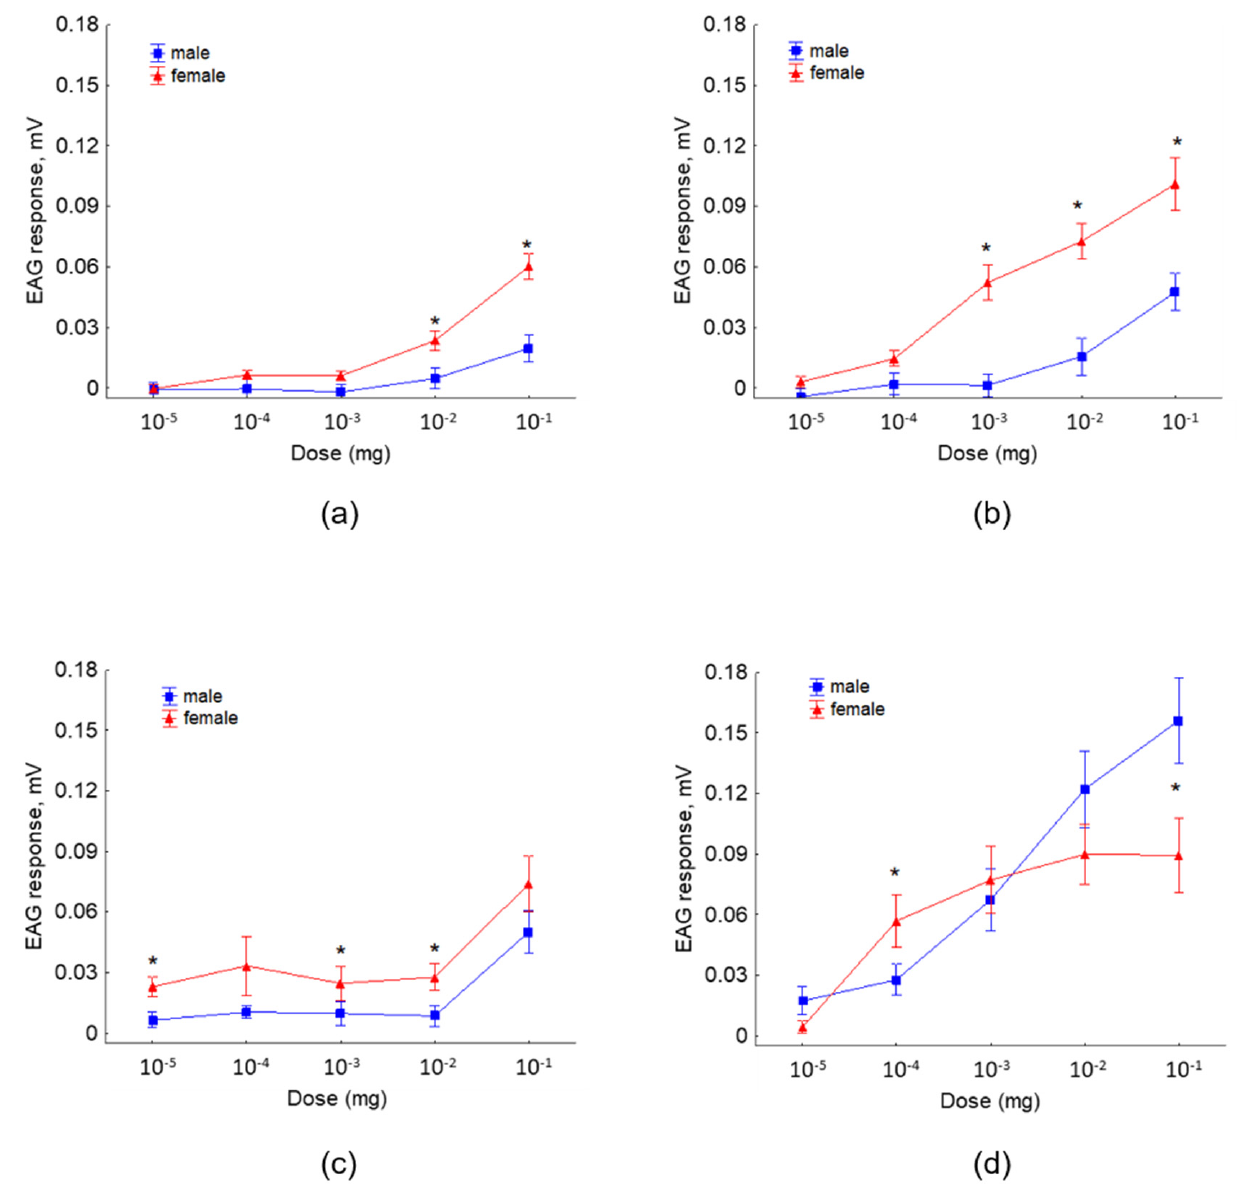
Figure 5. EAG responses (mean amplitude ± standard error (SE), mV) of R. cerasi male and female antennae to different doses (10 − 5 to 10 − 1 mg) of synthetic: ( a ) 3-methylbutyl acetate, ( b ) 3-methylbutyl propionate, ( c ) 2-methyl-1-butanol, and ( d ) 3-methyl-1-butanol. The asterisk denotes significant differences in EAG responses between sexes (paired t test, p < 0.05); each EAD test was replicated 13 times and each antenna used was from a different fly.